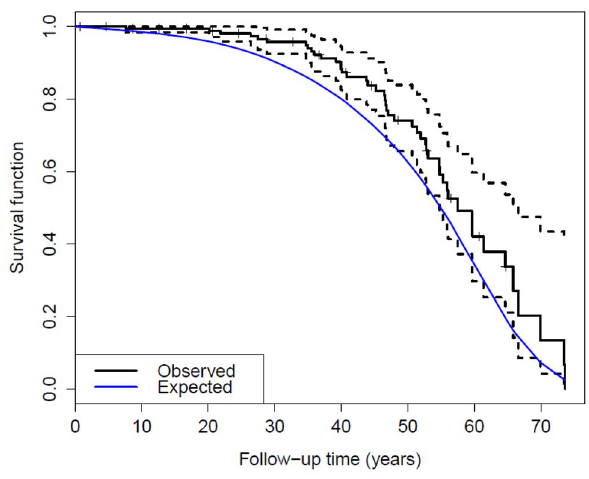
Figure 2. French Olympic rowers’ observed and expected survival curves. Rowers’ observed survival is represented by the solid black curve and its dashed confidence interval. The blue curve refers to the expected survival derived from the matched general French population.